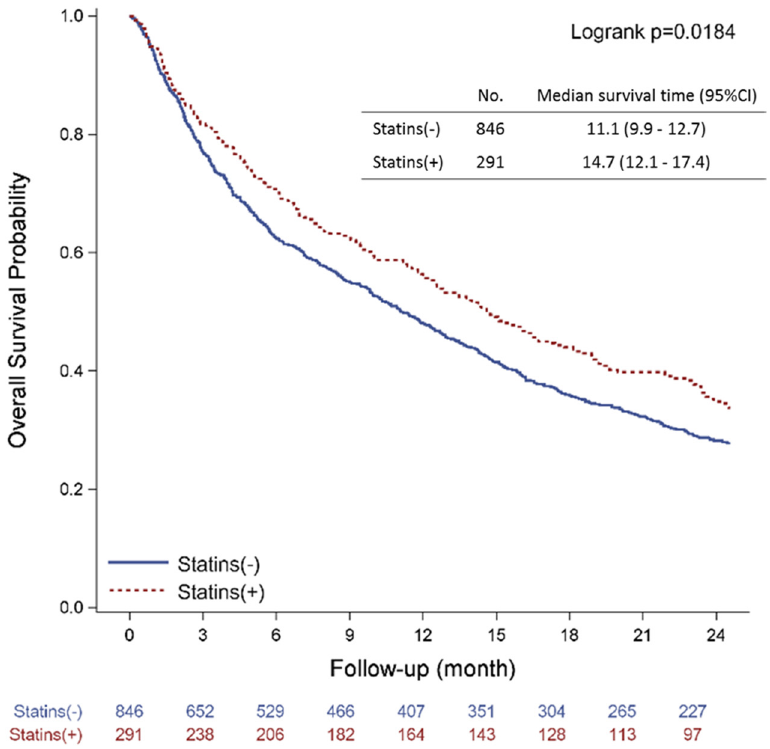
Figure 7. Kaplan–Meier plot of all-cause mortality among NSCLC stage IV patients with cancer- related pleural effusion, with and without statin use, over 24 months. Table 2. Cox proportional-hazards model of all-cause mortality and lung cancer-related mortality among NSCLC stage IV patients with cancer-related pleural effusion with and without statin use.